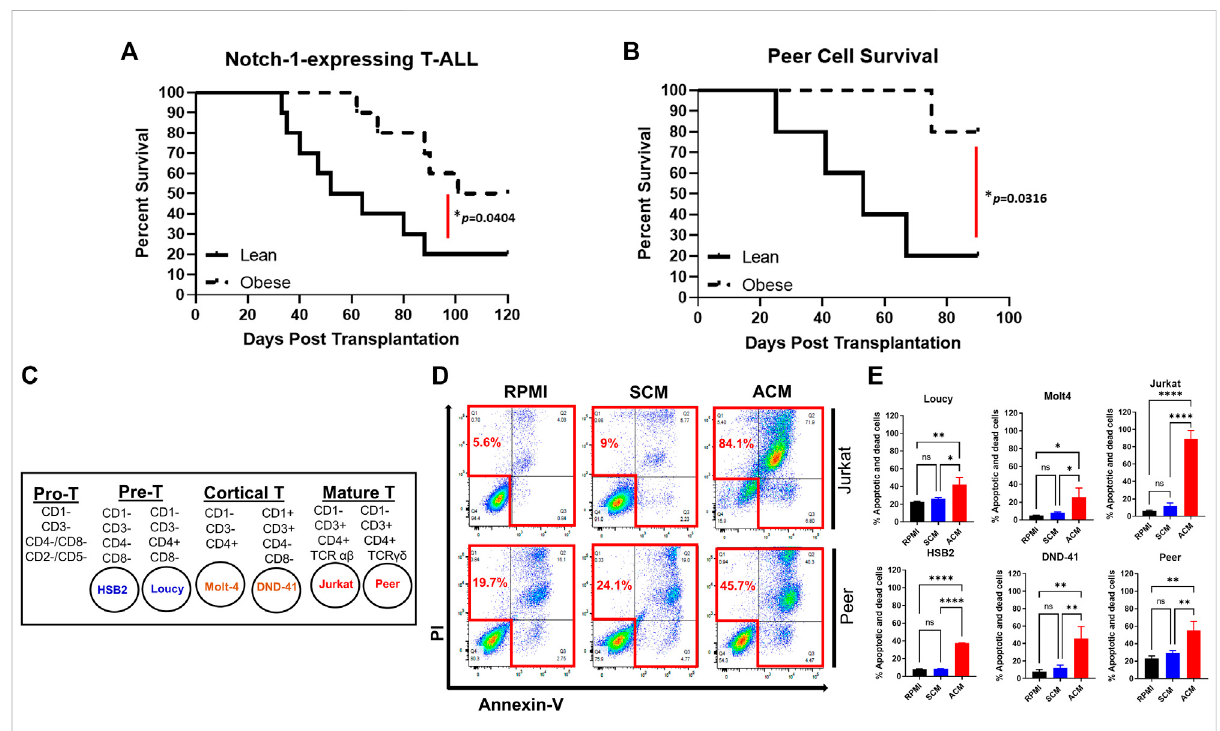
FIGURE 1 Obesity protects against T-ALL pathogenesis with adipocyte-secreted factors being cytotoxic to human T-ALL cells. (A) Murine c-kit + cells were isolated from the spleens of C57BL/6 mice and transduced with lentivirus expressing NOTCH1. NOTCH1-expressing c-kit cells were injected intravenously via tail vein delivery (5 × 10 5 cells/mouse) into recipient mice ( n = 10/group) and their survival was monitored. (B) Human T-ALL cells (Peer cells) were injected (10 5 cell/mouse) into lean or obese immunocompromised (NOG) mice as described earlier and survival was monitored. (C) List of human T-ALL cell lines used in this study depicting their maturation state as determined by surface immunophenotyping. This fi gure was adapted from Burger et al. (1999). (D) Human T-ALL cells, Jurkat, and Peer, were cultured in RPMI (control condition), stromal cell- conditionedmedia(SCM),oradipocyte-conditionedmedia(ACM)for72 handcelldeathwasassessedusingAnnexin-V/PIstainingasdetermined via fl owcytometricanalysis.Primarydatafromarepresentativeexperimentisshown. (E)